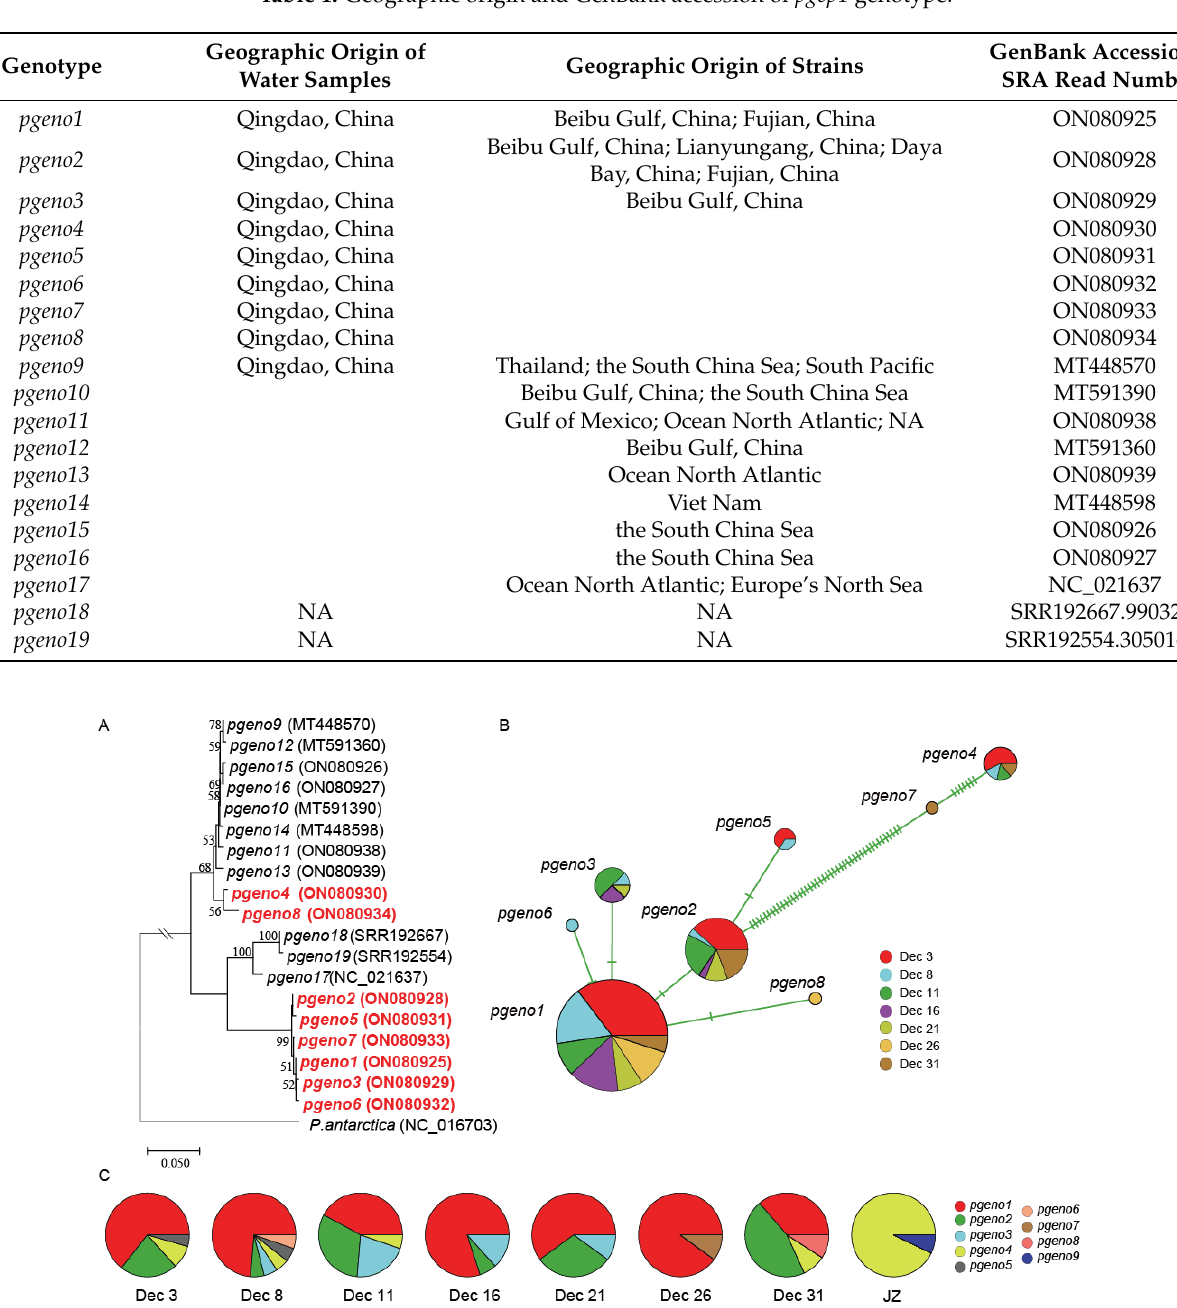
Table 1. Geographic origin and GenBank accession of pgcp1 genotype.